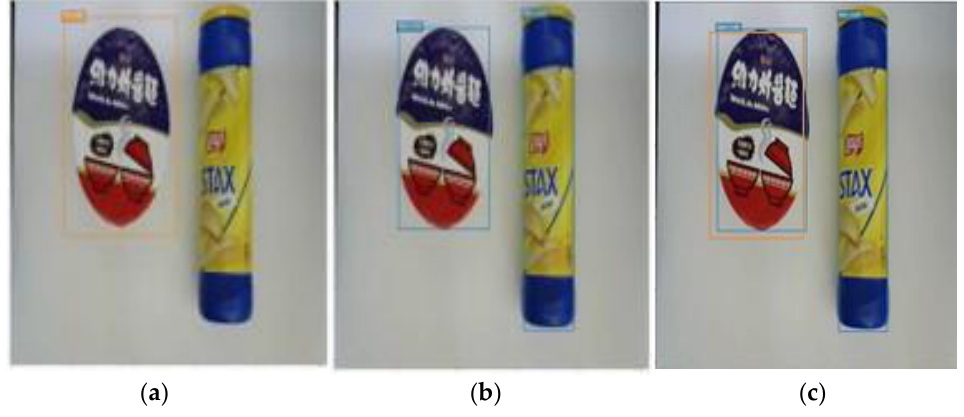
Figure 8. ( a ) Classification model; ( b ) object detection; ( c ) IoU of two models.